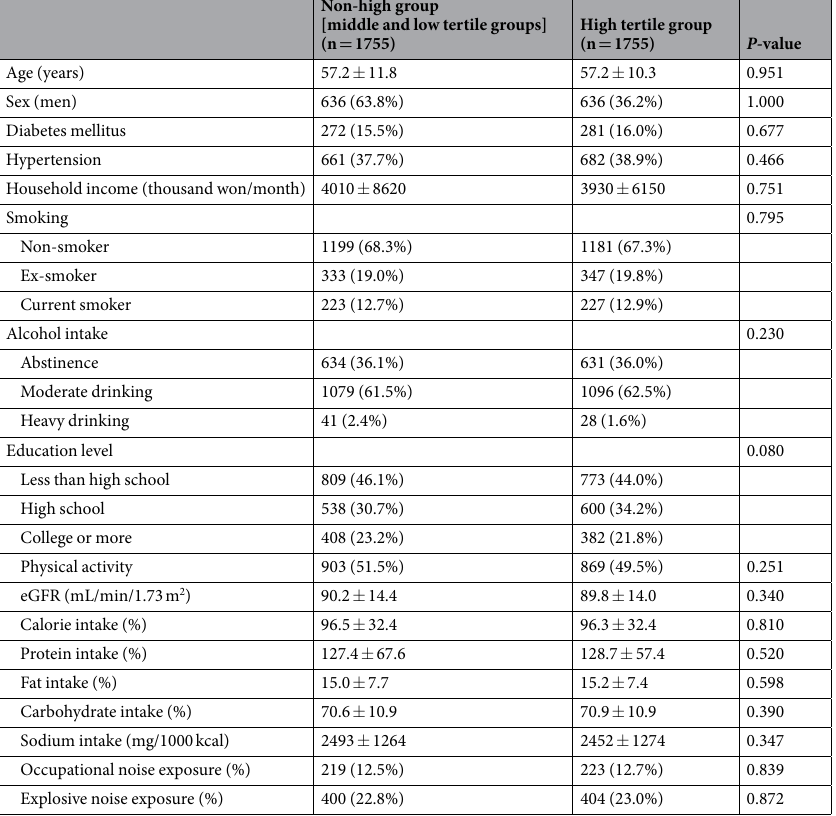
Table 5. Clinical characteristics of participants matched by based on propensity scores and grouped by potassium intake. The data are expressed as numbers (percentages) for categorical variables and means ± standard deviations for continuous variables. The P- values were tested using t -tests for continuous variables and Pearson’s χ 2 test or Fisher’s exact test for categorical variables. Abbreviation: eGFR, estimated glomerular filtration